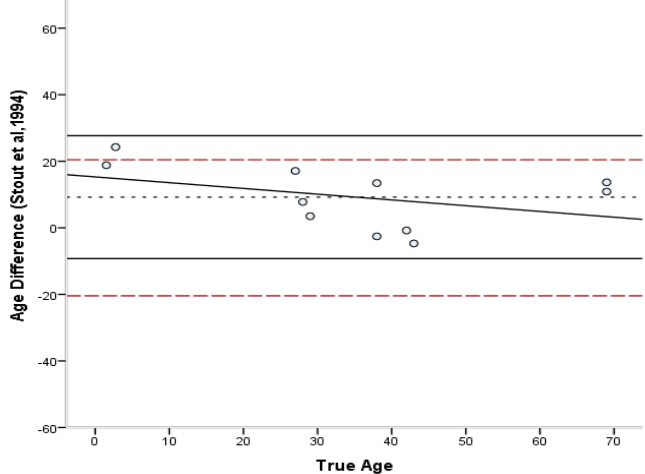
Figure 3. Bland–Altman plot for Stout’s et al. [26] method illustrating the differences between known and estimated ages for the ribs against the known age. Depicted are 95% limits of agreement (black horizontal lines), mean difference/bias (black dotted line), best fit lines and 95% confidence intervals of the SEE for each method (dashed lines). R 2 of the best fit line: 0.160.